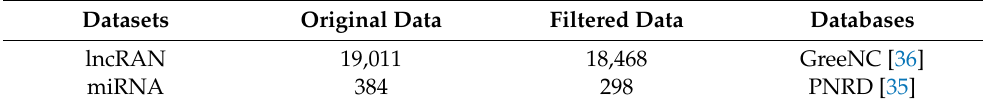
Table 2. Wheat (Triticum aestivum) dataset